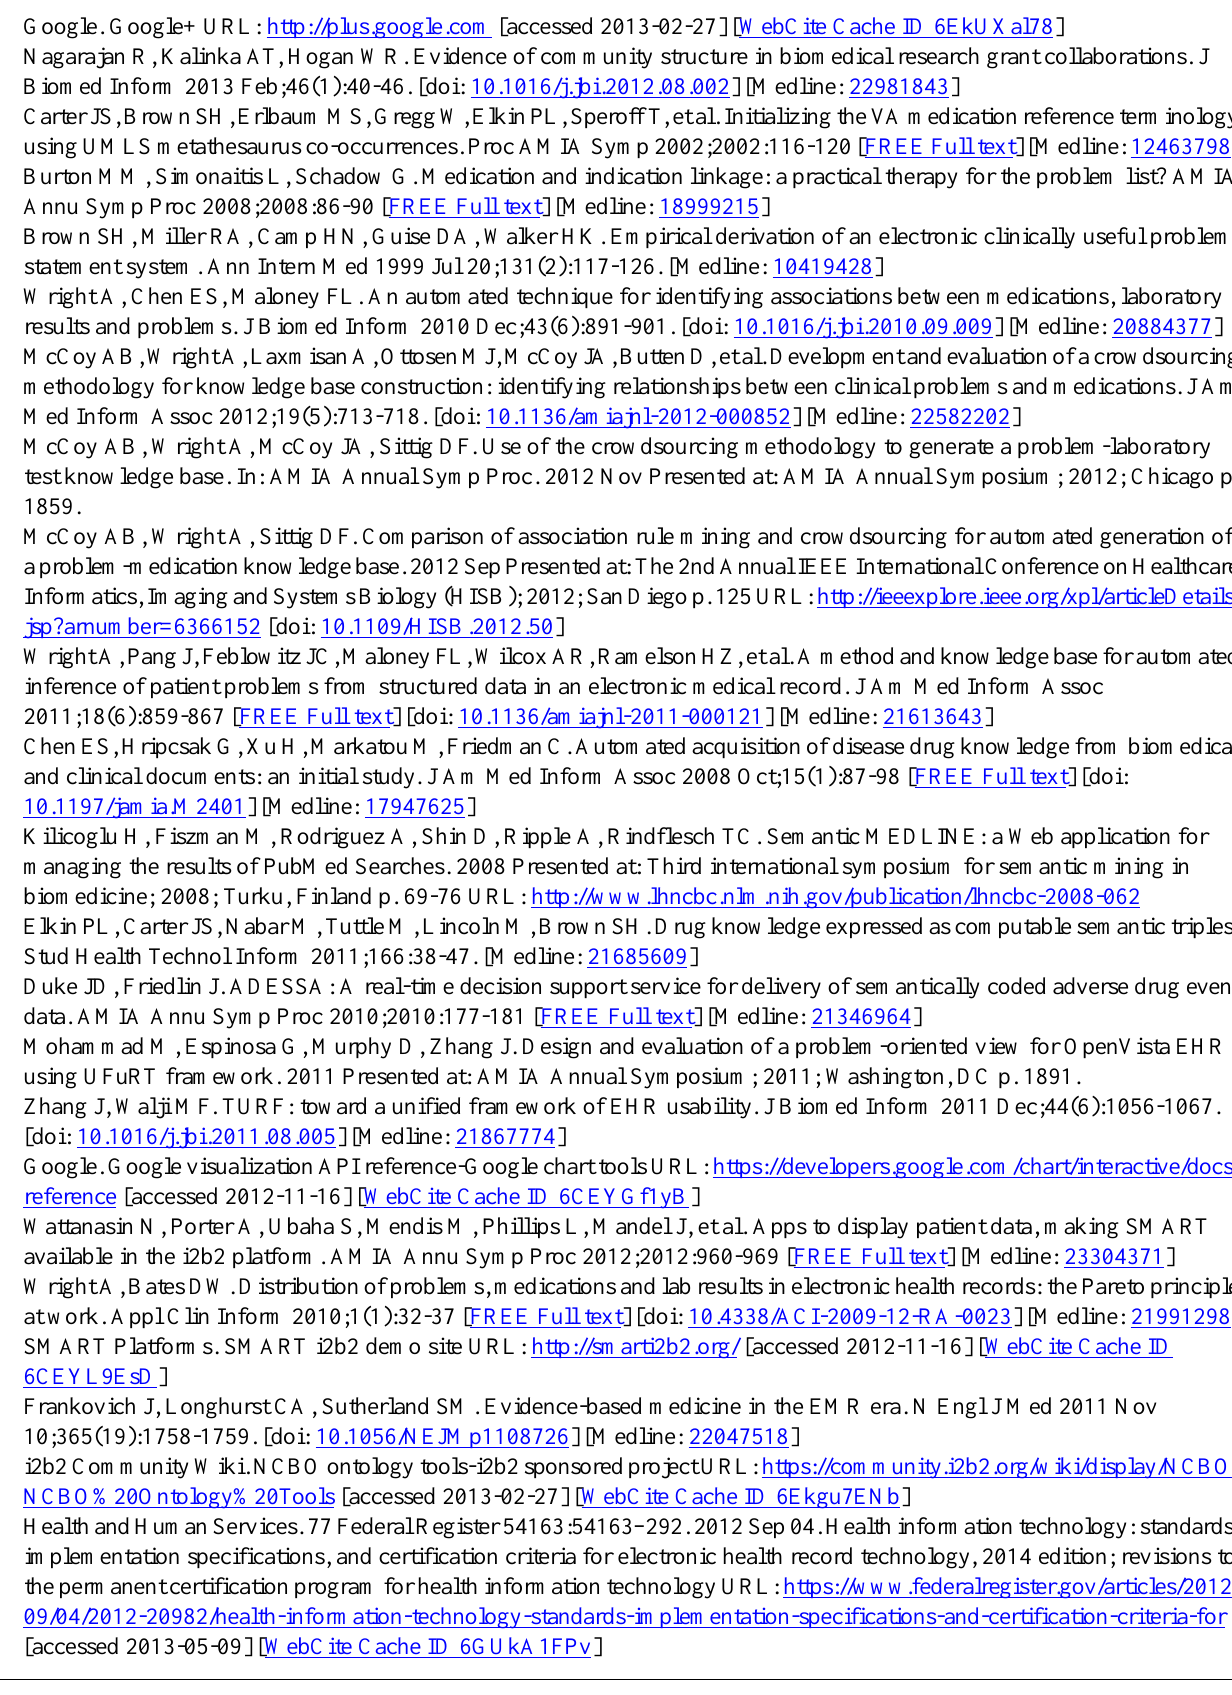
API: application programming